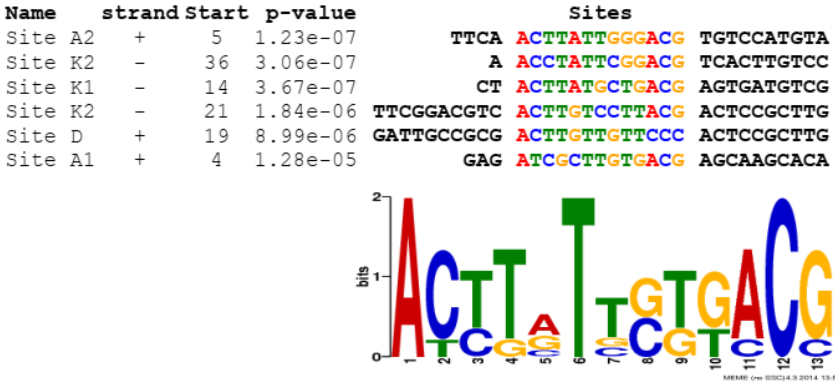
Figure 4. Common sequence motif found by the MEME algorithm within the SCO3932 binding sites identified in DNase I footprint experiments.